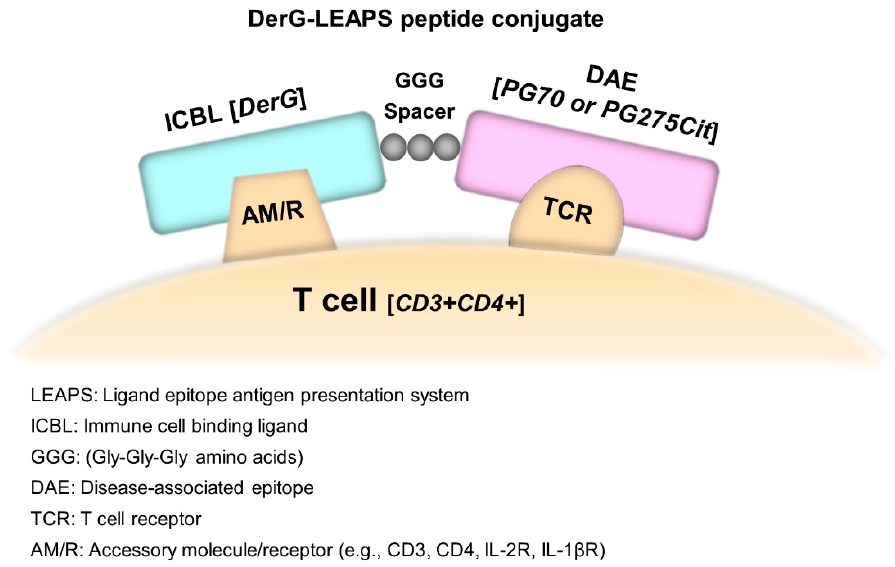
Figure 1. Model mechanism of action of a DerG-LEAPS conjugate. Based on findings of [21] and [3] for CEL-4000 (DerG-PG70) and earlier studies [29–32] for the G or DerG element. For DerG-LEAPS, the epitope peptide binds to the TCR of cognate CD4+ cells, while the DerG portion can bind to another receptor (including CD3, CD4, or other accessory molecules). A glycine triplet (GGG) is inserted as a spacer between the DerG and epitope peptides. DerG-LEAPS can promote the secretion of anti-inflammatory cytokines (IL-4, IL-10) by CD4+ Th2 or Treg cells. For J-LEAPS conjugates, the initial interaction of the J-ICBL promotes interaction with a DC which initiates maturation, IL-12p70 secretion, and antigen presentation to CD8+ T cells [17] (IL-1 β R and IL-2R are receptors for IL-1 β and IL-2, respectively).